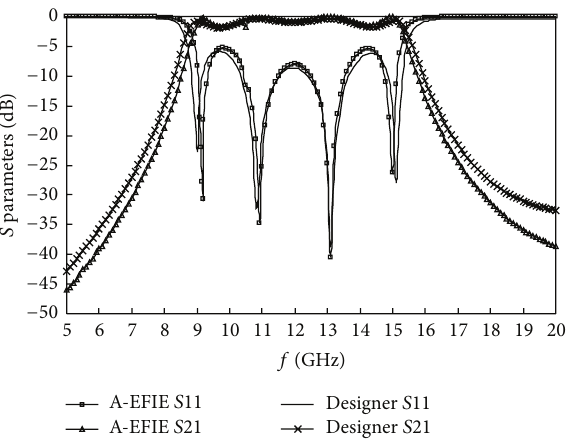
Figure 5: The VV-polarization bistatic RCS for an almond at 3 GHz. w Figure 6: The periodic SRR structure in microstrip bandpass filter.